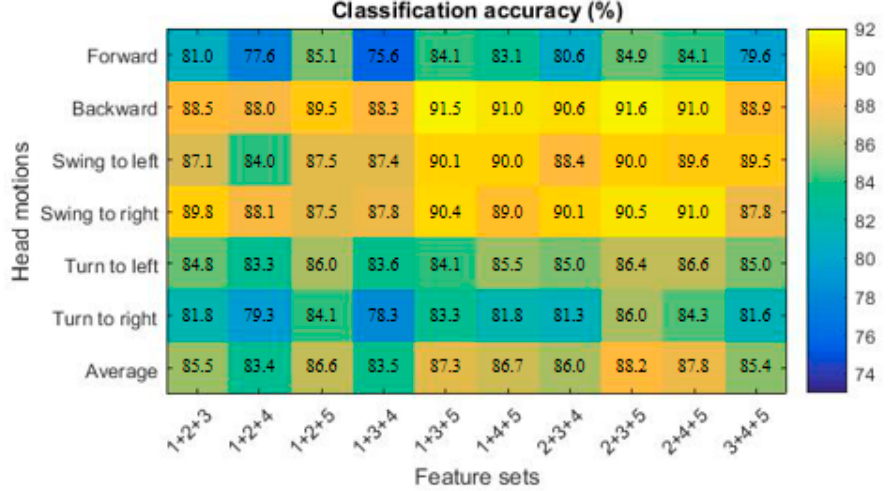
Figure 6. The classification accuracy of each head motion using three feature sets.